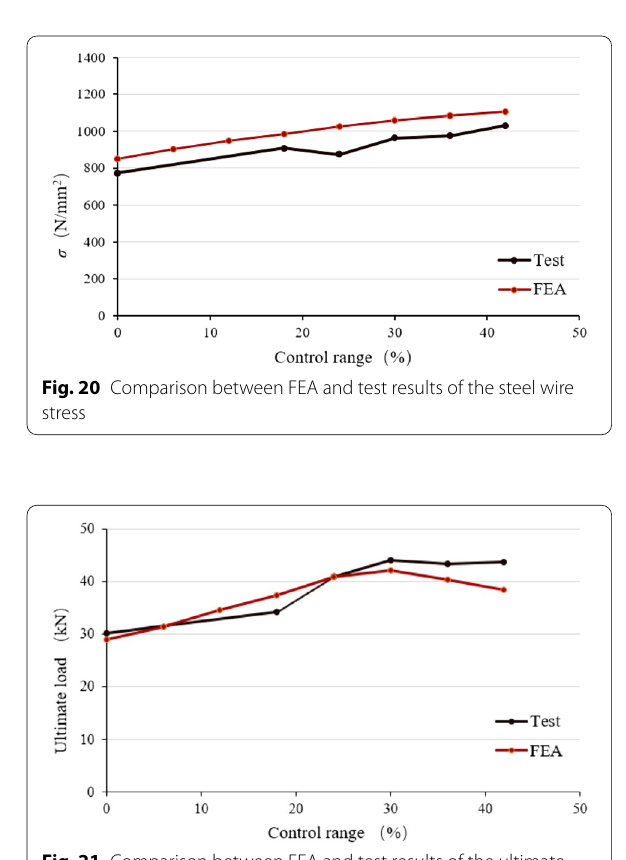
Fig. 21 Comparison between FEA and test results of the ultimate